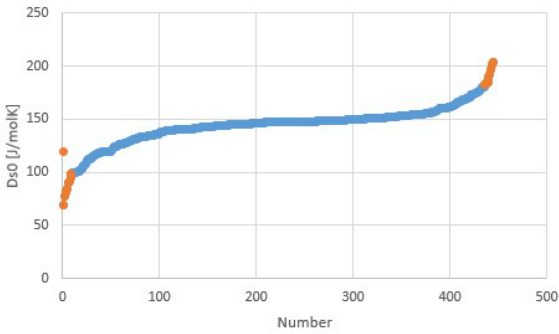
Figure 11. Transition entropy at 1 atm for hydration transitions of salts. Orange points with highest and lowest transition entropies correspond to the orange points in Figure 10. The transition entropy of 118.9 J/mol for water evaporation is also plotted as the left-most point and differs considerably from the average, as expected.